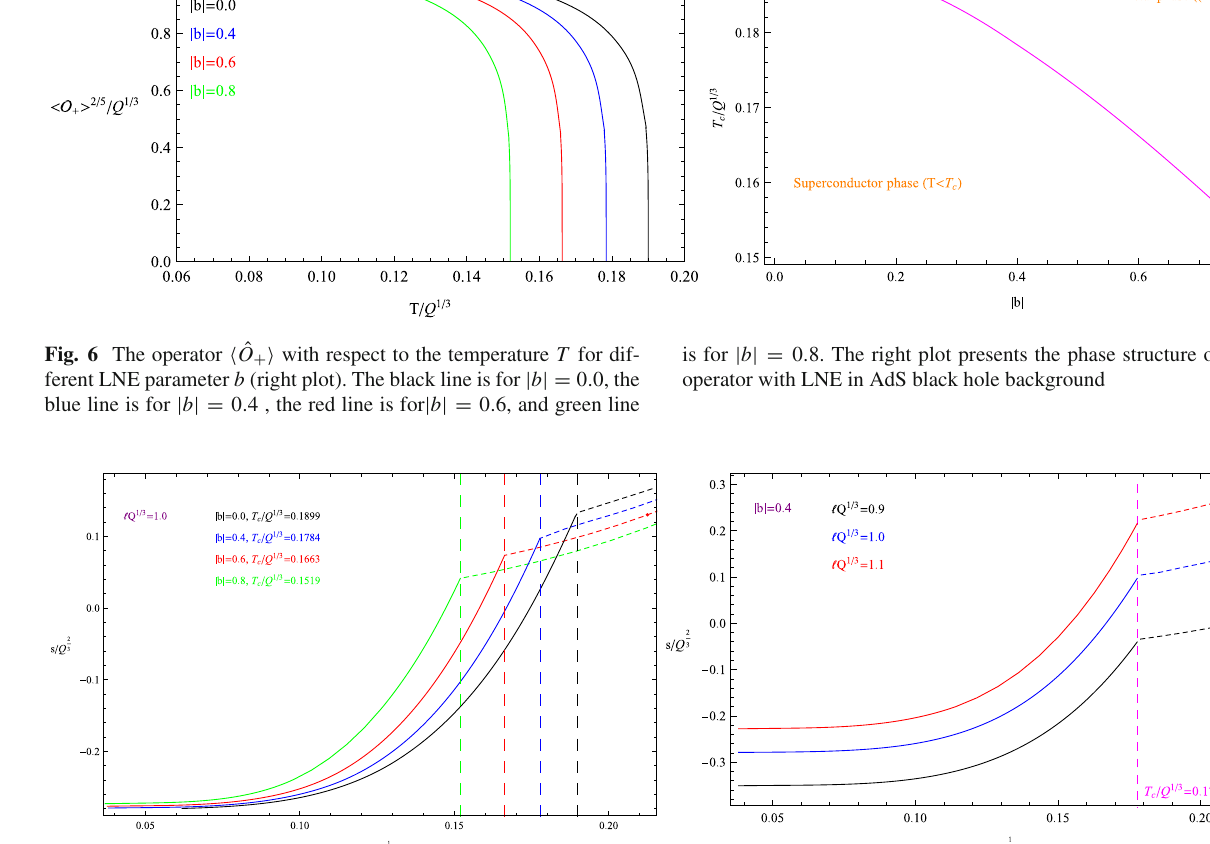
| b | = 0 . 8. The three curves in the right figure from button to top cor- respond to increasing (cid:2) , i.e., (cid:2) Q 1 / 3 = 0 . 9 (black), 1.0 (blue) and 1.1 (red)